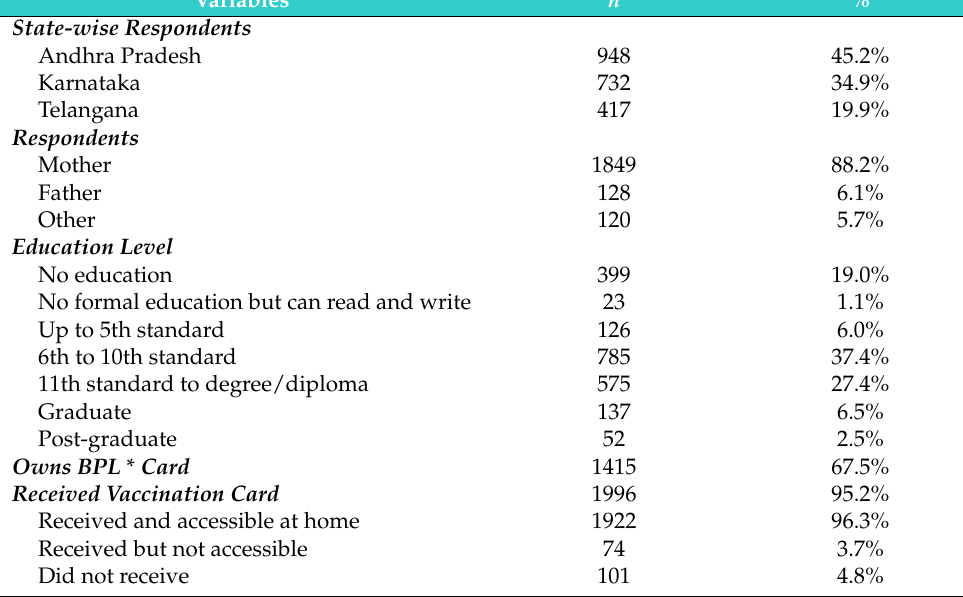
Table 2. Characteristics of study participants ( N = 2097).